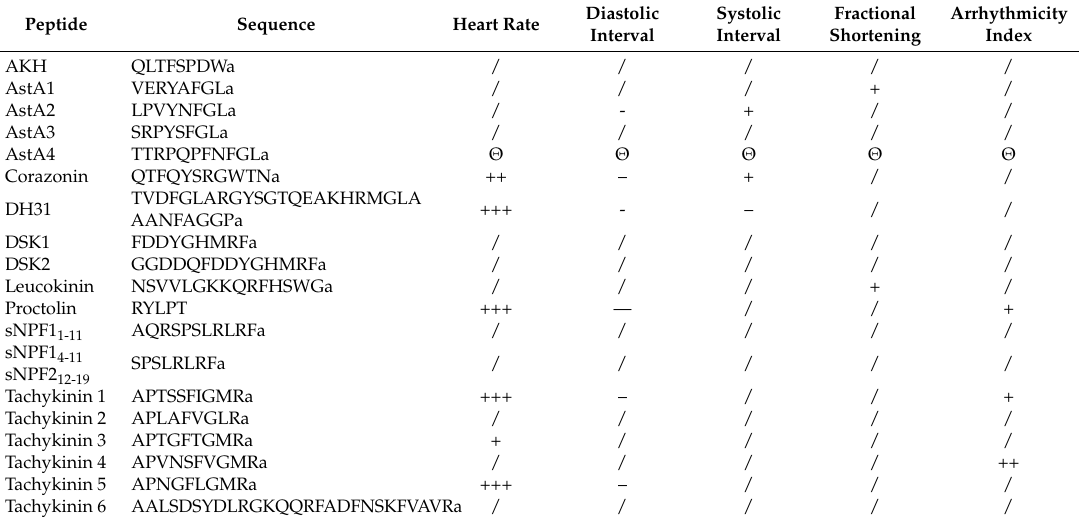
Table 1. Peptides used in this study and corresponding effects on distinct heart parameters in semi-intact larvae.